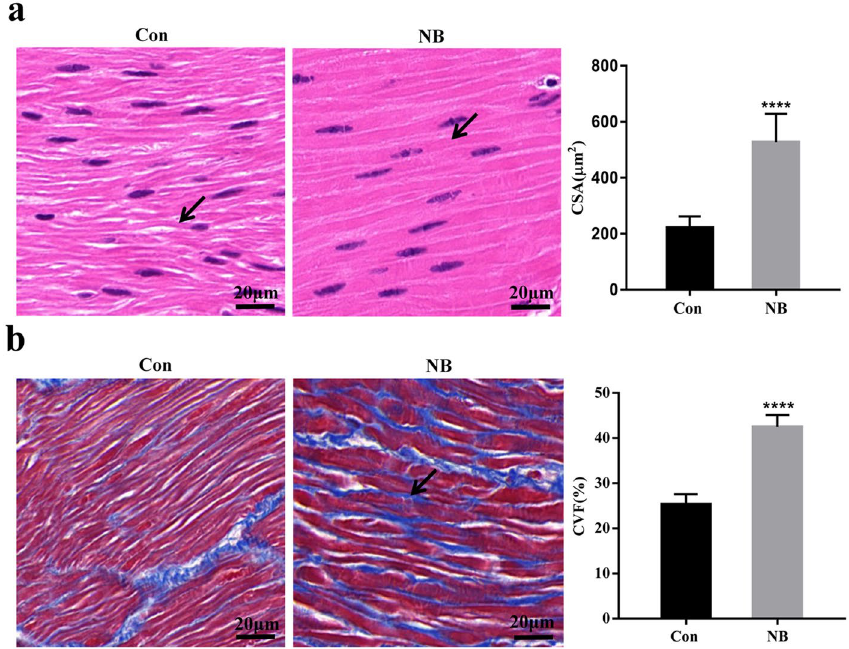
Figure 2. HE and Masson staining of bladder tissue in the NB group and control group: ( a ) HE staining of bladder tissue. The red area in the figure represents the detrusor cytoplasm, and the purplish-blue area represents the nucleus. The black arrow indicates detrusor cells. The CSA values of the two groups were compared. The bars indicate 20 μm. ( b ) Masson staining of bladder tissue. The blue area in the figure represents collagen fibres, and the red area represents muscle fibres. The white arrow indicates collagen fibres. The CVF values of the two groups were compared. The bars indicate 20 μm. The data are shown as the means ± SD. **** p < 0.0001 versus the control. Student’s t test. CSA, mean cross-sectional area. CVF, Collagen volume